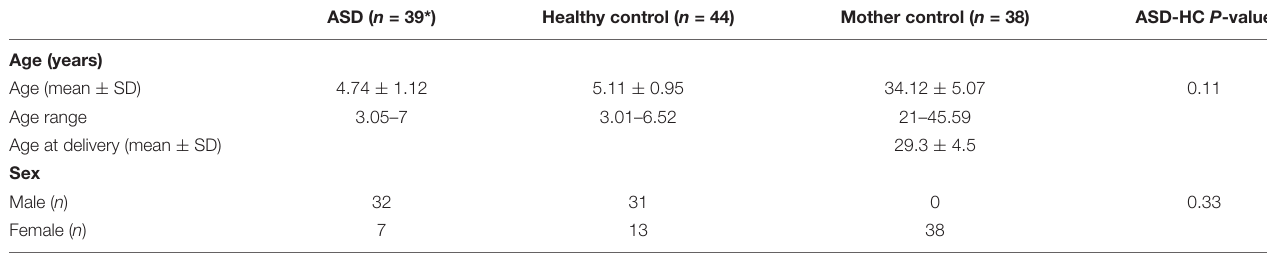
TABLE 1 | Demographic information of the study participants.